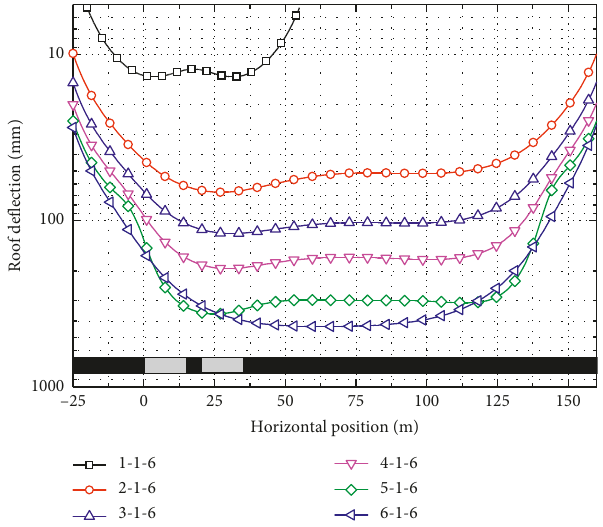
Figure 8: Deflection curves of the roof in the first to sixth mining step of each